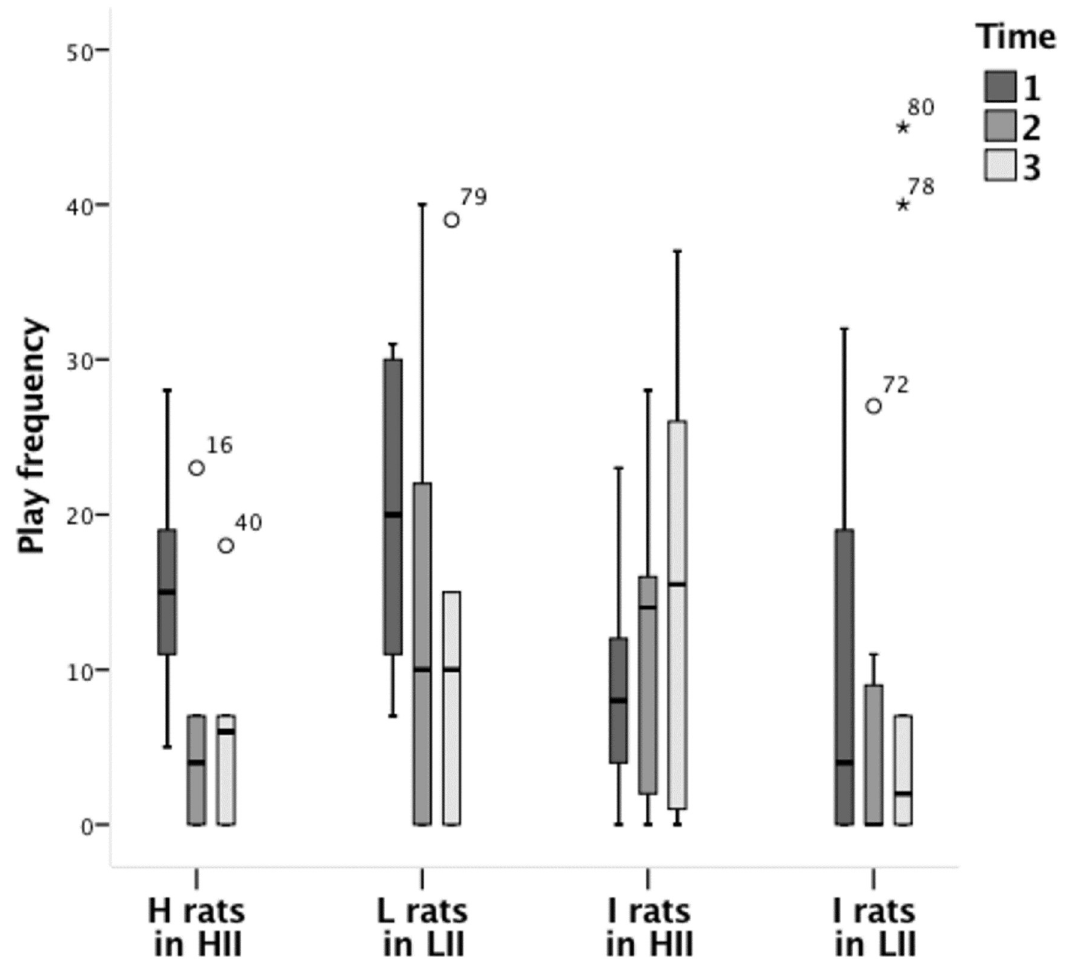
Fig 5. Boxplots of pinning behaviour frequencies across time for seeders and I rat pairs from the heterogeneous groups. The box represents the middle 50% of the data, while the upper and lower whiskers show the extreme data points, excluding outliers. The horizontal line within the box represents the